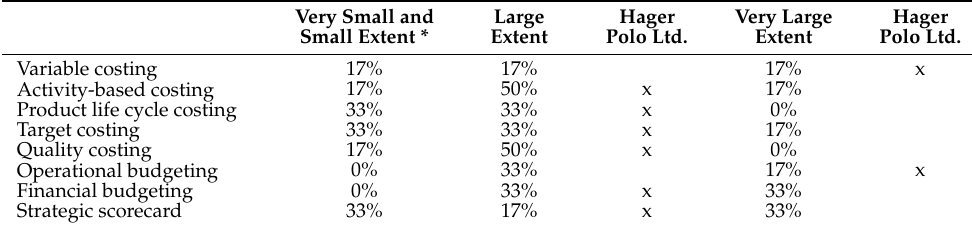
Table 5. Assessment of the extent of individual managerial accounting tools used in